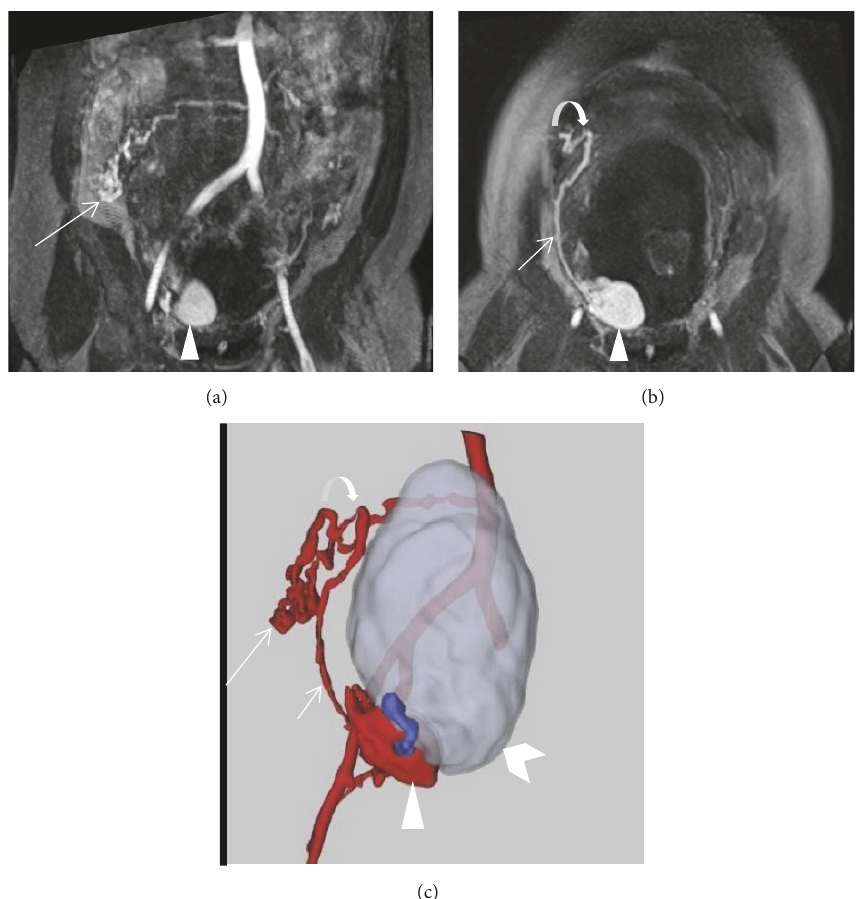
Figure 4: Coronal T1 MRA and 3D surface rendered reconstruction (Vital Images (cid:3) postprocessing software) of the aberrant right ovarian artery branch feeder at 19 weeks of gestation. The proximal right ovarian artery originates from the aorta and courses into a tangle of vessels (long arrows) in the right abdomen ((a) and (c)) before penetrating the myometrium (curved arrows) ((b) and (c)) and extending caudally (short arrows) as an arcuate artery to the lesion. Pseudoaneurysm (arrowhead), uterine cavity (chevron), and aortoiliac vessels. Draining vein